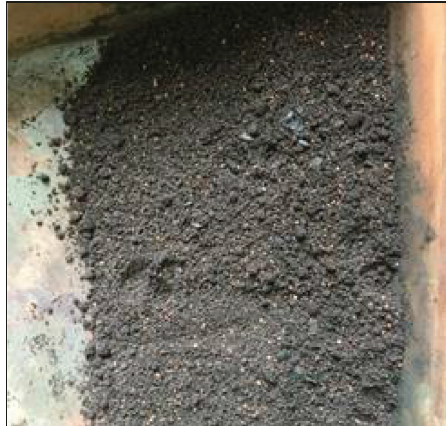
Figure 4: Material mixing.